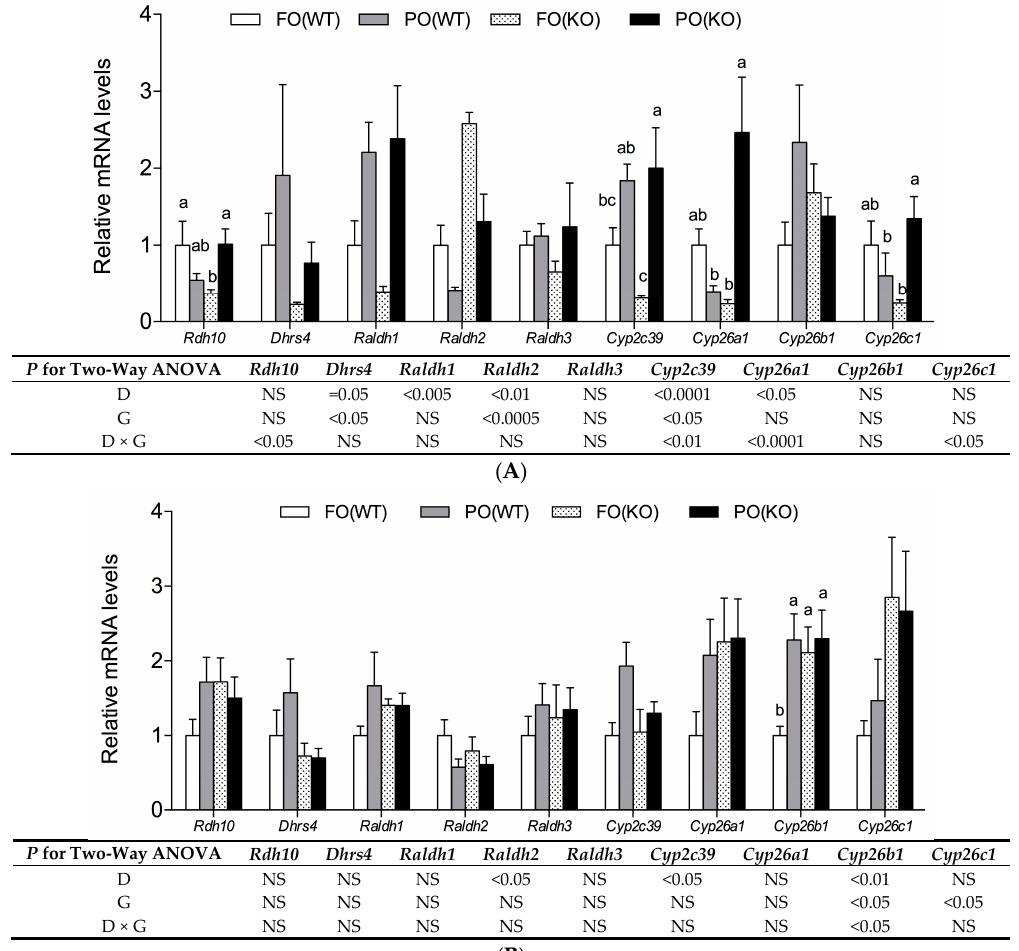
Figure 2. Levels of mRNA for genes associated with RA metabolism in maternal liver ( A ) and fetal liver ( B ) of WT and KO mice receiving FO or PO diets during pregnancy. Samples were collected at pregnancy day18. The value for the FO(WT) group was taken as 1. Data are mean ± SEM, n = 5. Results of two-way ANOVA are shown in table (D, diet; G, genotype; D × G, interaction; NS, not significant). When there was a significant interaction between D and G, the significance of differences among groups was further analyzed by one-way ANOVA and Duncan’s multiple range test; a–c Values without a common superscript letter differed ( P < 0.05).